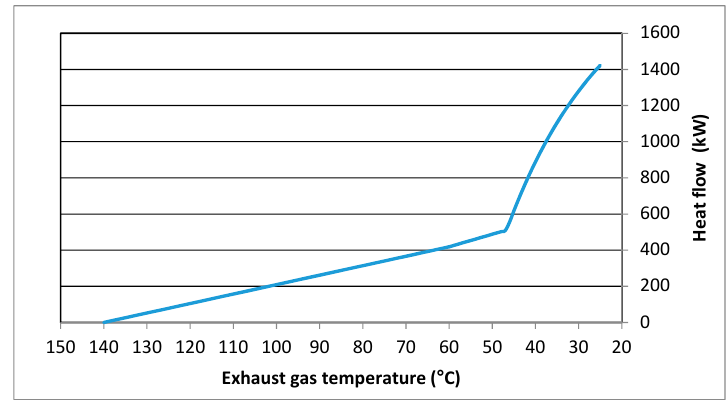
Figure 2. The low-temperature heat flow with an additional cooling of the flue gases hot water boiler (HWB).